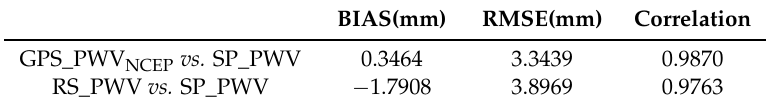
Figure 13. Scatter plot between SP_PWV, GPS_PWV NCEP , and RS_PWV. Table 6. Statistics of differences between SP_PWV, GPS_PWV NCEP , and